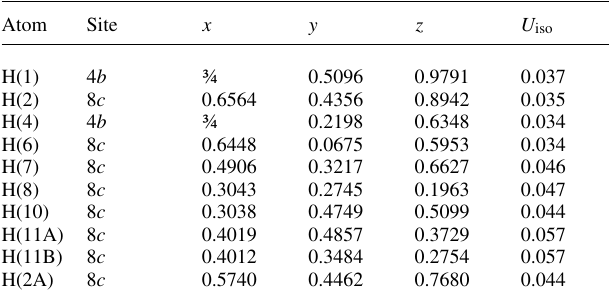
Table 2. Atomic coordinates and displacement parameters (in Å 2 )